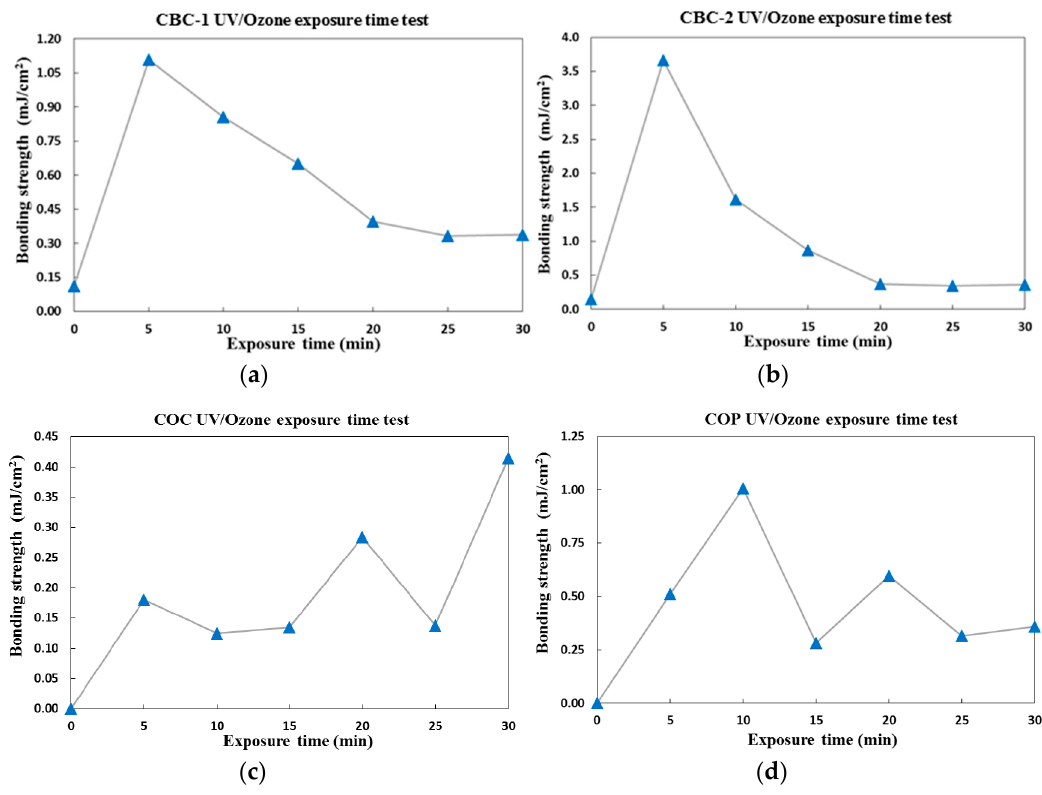
Figure 6. UV/ozone bonding strength with exposure times from 0 to 30 min for ( a ) CBC-1, ( b ) CBC-2, ( c ) COC, and ( d ) COP thermoplastic substrates. The bonding strength values are the average of three individual measurements.